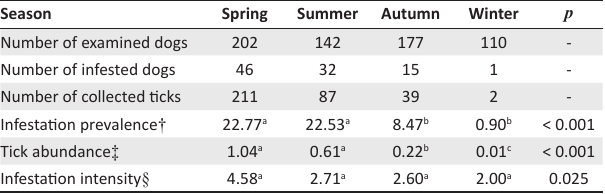
TABLE 4: Seasonal variation of tick infestation of dogs in the Bejaia province, northeastern Algeria. Season